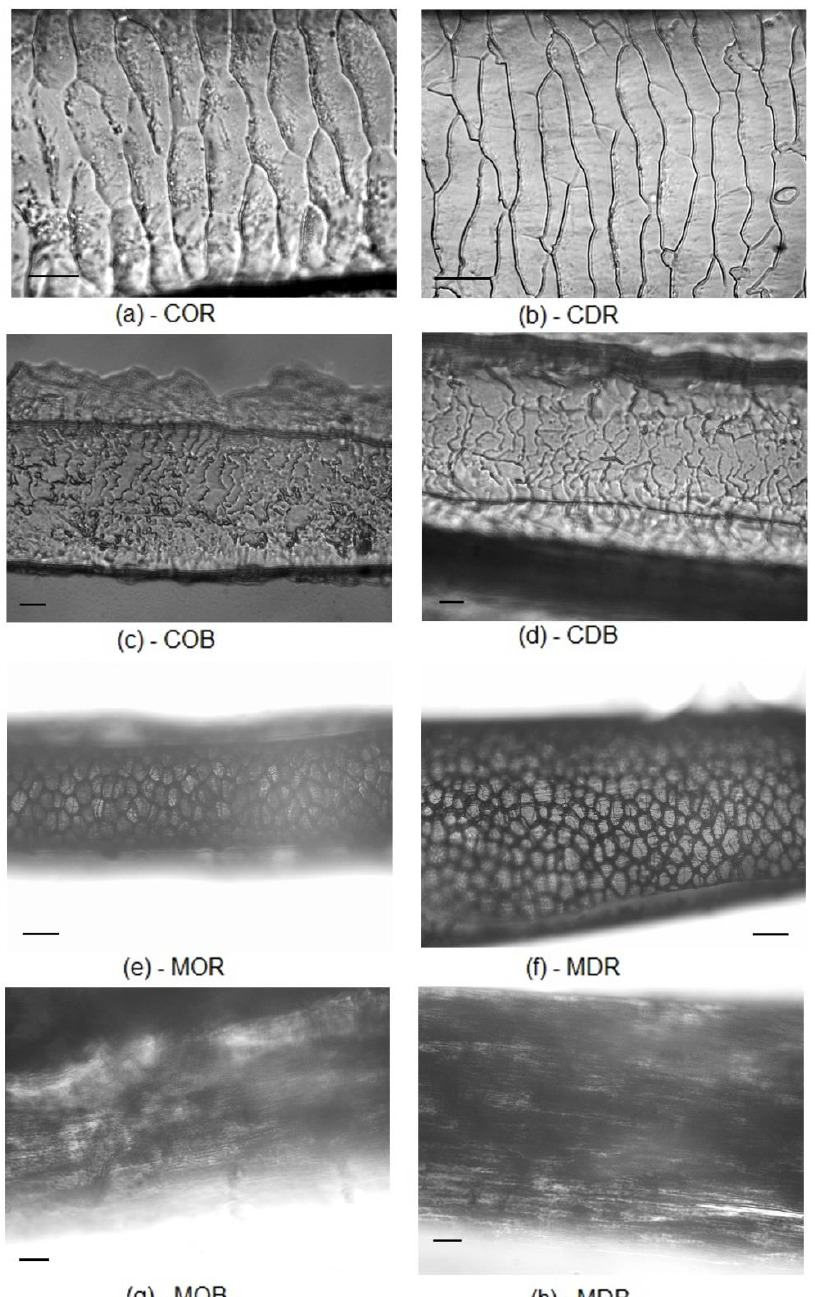
Figure 5. Cuticular (C) and medullar (M) pattern of original (O) and digested (D) roe deer (R; Capreolus capreolus ) and boar (B; Sus scrofa ) hairs; cuticular pattern: ( a ) original roe deer, ( b ) digested roe deer, ( c ) original boar, ( d ) digested boar; medullar pattern: ( e ) original roe deer, ( f ) digested roe deer, ( g ) original boar, ( h ) digested boar; scale line ( ― ) on figures a–d and g–h: 25 μm, on Figures e–f: 100 μm.